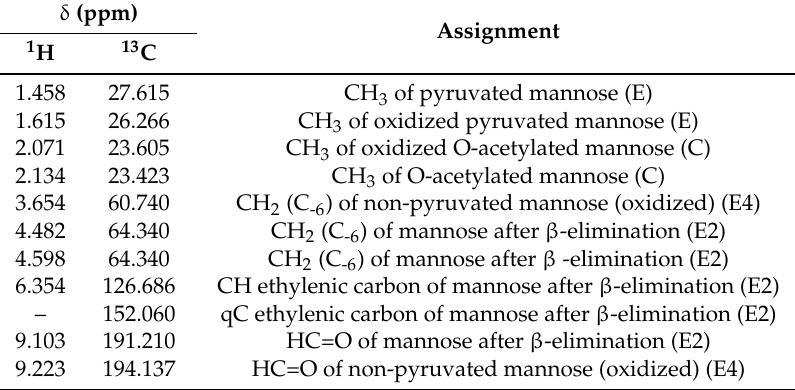
Table 1. Relevant spectroscopic data ( 1 H and 13 C NMR) of oxidized xanthan gum in D 2 O. δ